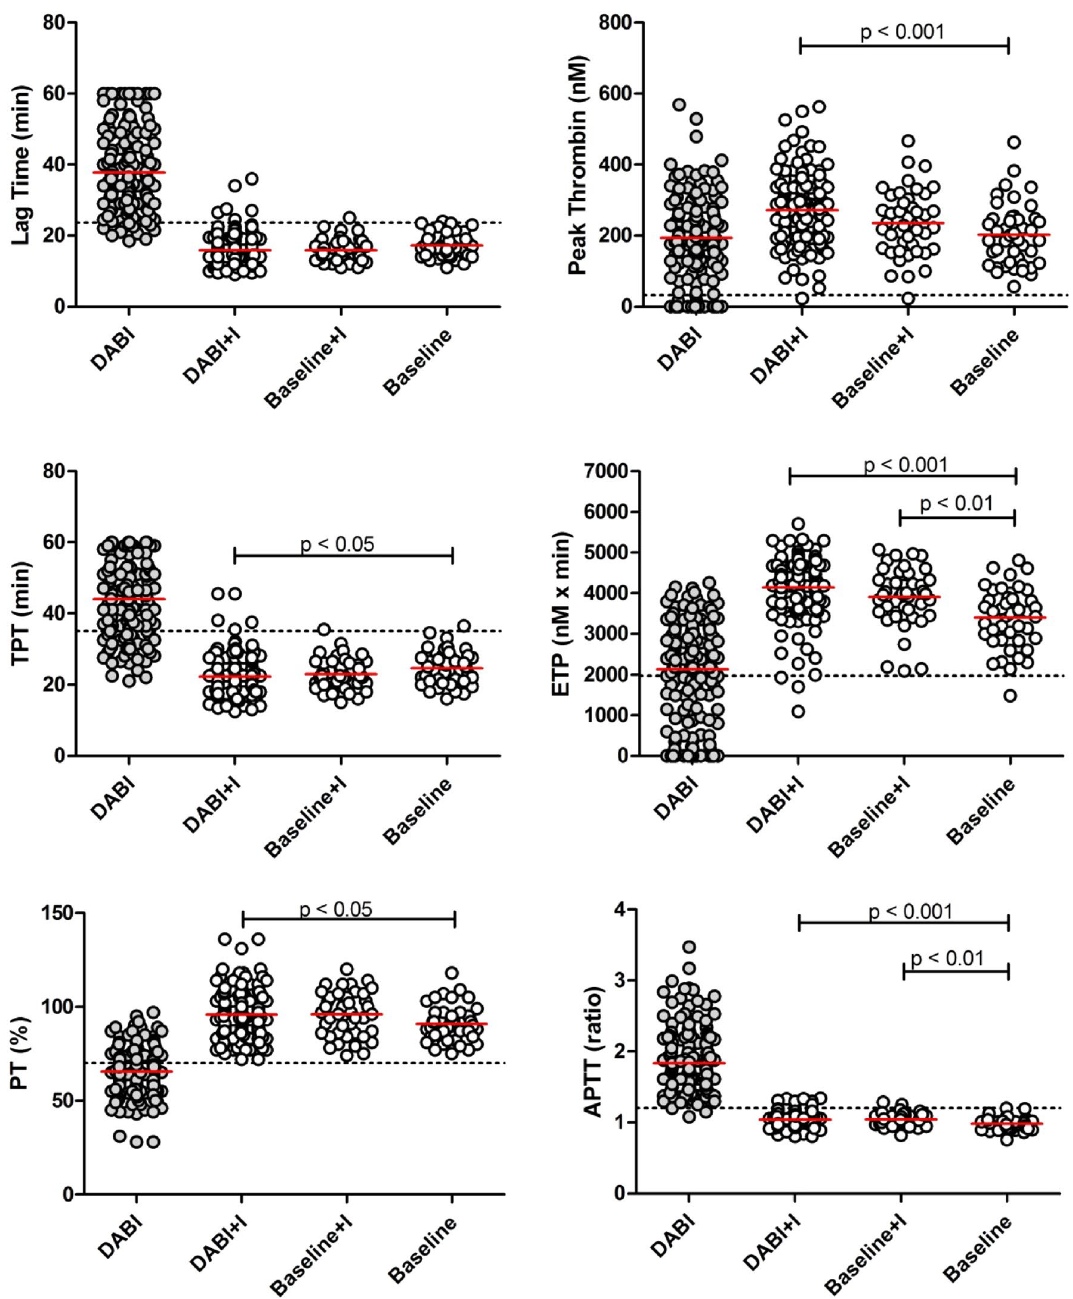
Figure 2. TGA (Lag Time, Peak Thrombin, TPT and ETP), PT and APTT are shown in baseline, baseline + I and DABI + I plasma. Dotted lines represent the lower (Peak Thrombin, ETP and PT) or the upper (Lag Time, TPT and APTT) reference values. Significant Tukey’s multiple comparison post-hoc test p values for DABI + I, baseline + I and baseline are shown. TGA Thrombin Generation Assay, TPT Time to Peak Thrombin, ETP Endogenous Thrombin Potential, PT Prothrombin Time, APTT Activated Partial Thromboplastin Time, Baseline samples without dabigatran, Baseline + I samples without dabigatran spiked with idarucizumab, DABI + I samples with dabigatran spiked with Dabigatran concentration correlated positively with TGA parameters Lag Time and TPT, and negatively with Peak Thrombin and ETP. Prolongation of Lag Time and TPT dependant on dabigatran concentration has already been reported by several studies, but these studies also reported a paradoxical increase of Peak Thrombin and ETP in samples containing dabigatran 13,15 . In all these studies, calibrated automated thrombinography (CAT) devel- oped by Hemker et al . was used 16 . In the CAT assay, each sample is calibrated with a calibrator that is influenced by dabigatran, which leads to a subsequent overestimation of thrombin activity. In our study, a TGA was used that generates a separate calibration curve for each substrate batch, so no calibrator is added to the samples. Secondly,